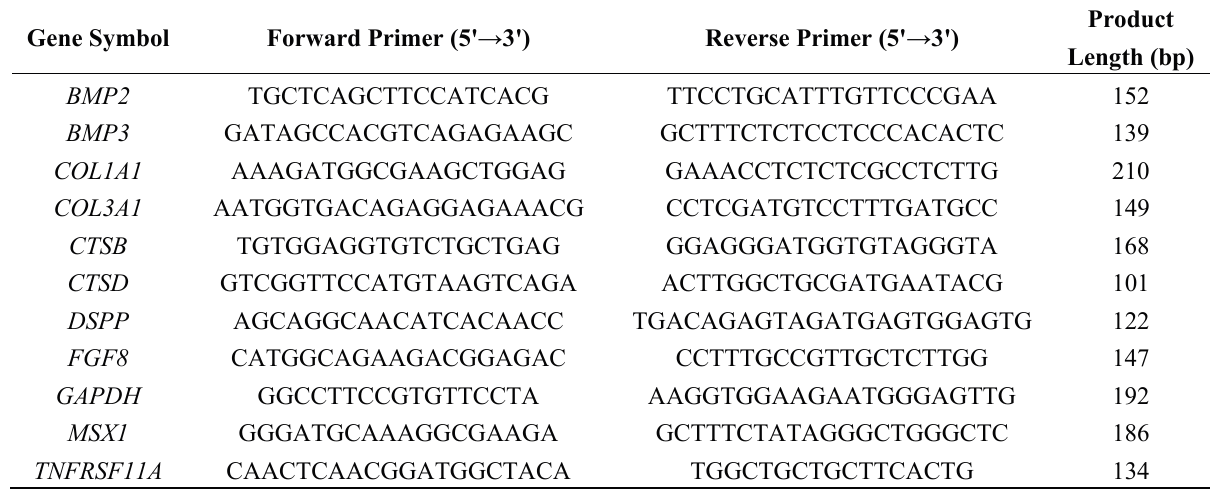
Table 2. Rat primer